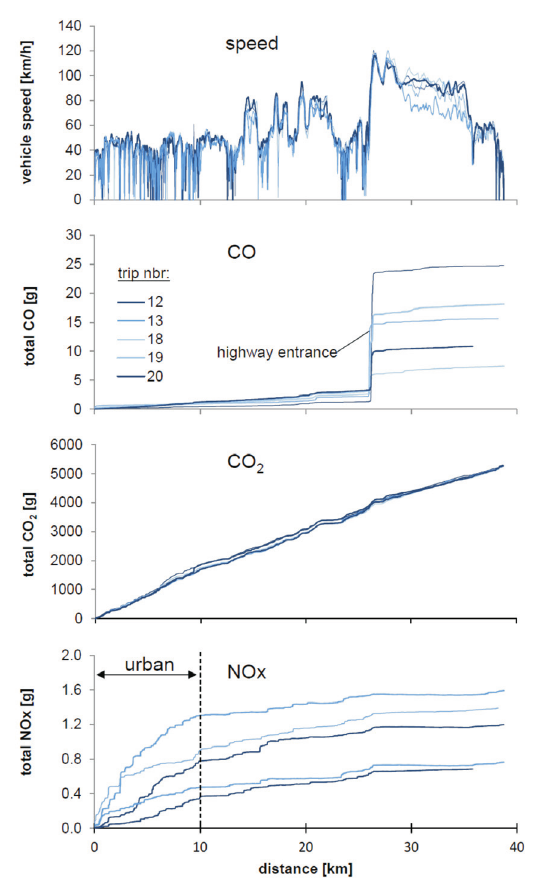
Fig. 9. Comparison of accumulated results from five road trips From all performed trips can be followed